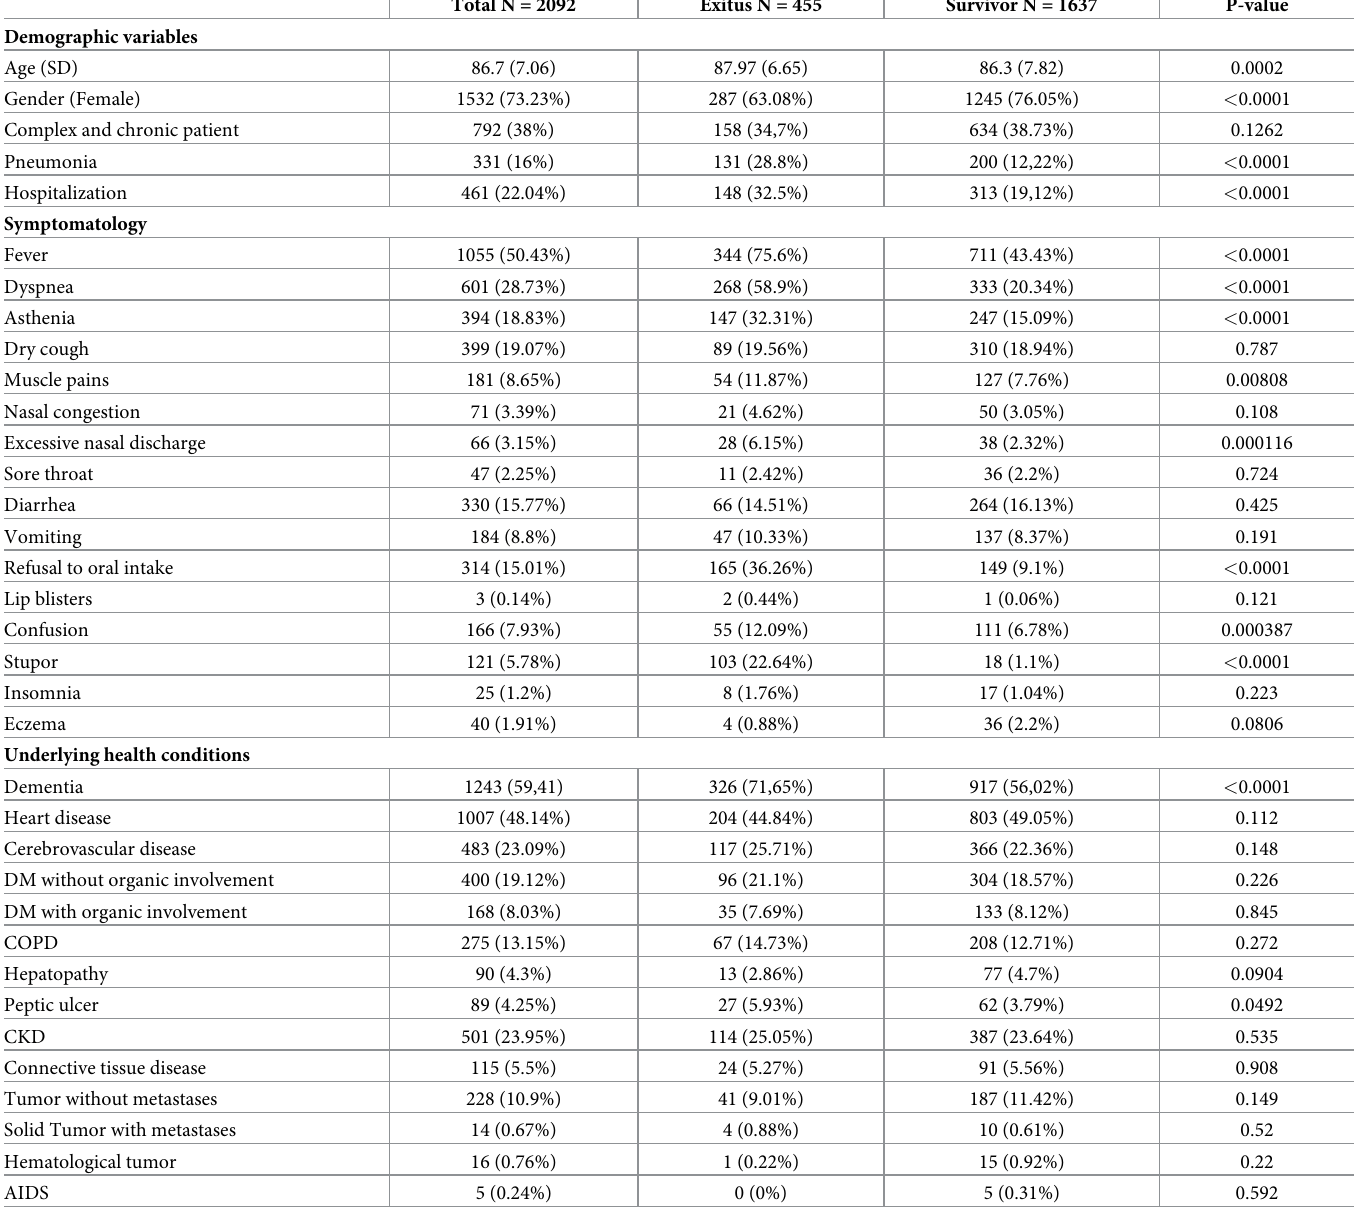
Table 1 shows demographic data and clinical symptoms of RT-PCR positive residents. The average incidence of positive RT-PCR in the total population of 80 facilities was 28% (ranging from 1% to 71%) of the total number of residents, and no regional significant differences were identified (data not shown). Table 1. Demographics, clinical features and underlined health conditions of the